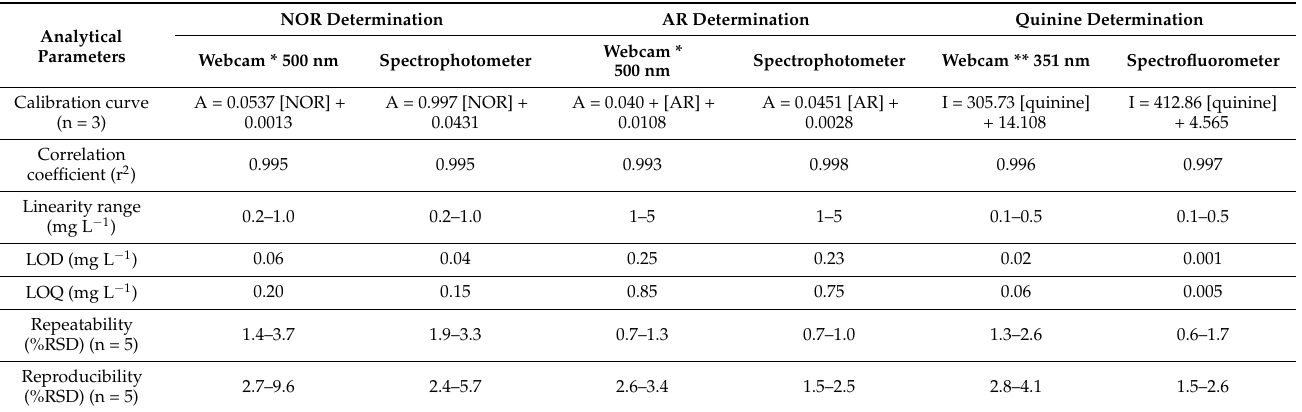
Table 1. Comparison of the results obtained using the proposed system with each conventional optical instrument.